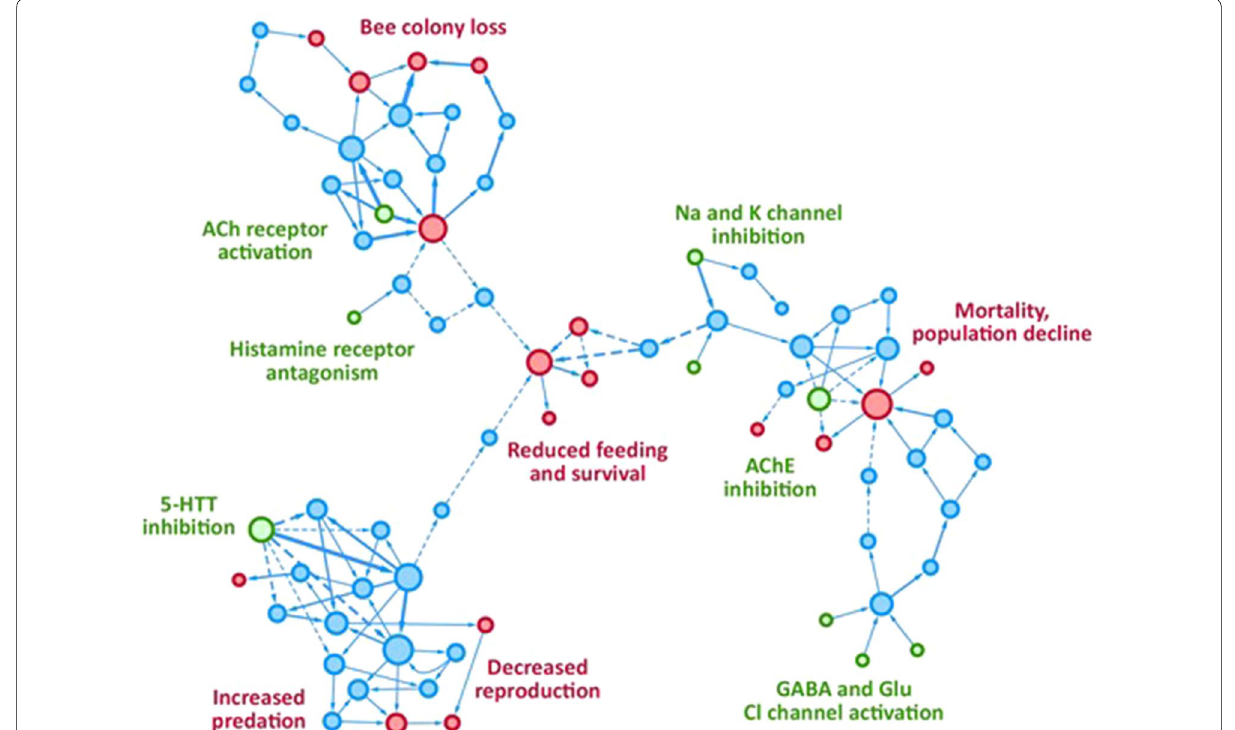
Fig. 4 AOP network showing all AOPs relevant to eco‑neurotoxicity that are available in the AOP‑Wiki (https ://aopwi ki.org; Accession date: April 30, 2018; AOP numbers 16, 77, 78, 79, 80, 82, 87, 88, 89, 90, 91, 93, 94, 95, 97, 98, 99, 113, 160, 161, 178, 195, 197, 203, 204; Network constructed using Cytoscape 3.6.1). Nodes in the network are key events (KEs), and edges represent key event relationships (KERs). Molecular initiating events are displayed in green, adverse outcomes in red. All other KEs are depicted in blue. Solid edges are adjacent KERs, dashed arrows are KERs that have been defined as non‑adjacent (see the OECD’s users’ handbook for developing and assessing AOPs for more information, [333]). Node size represents node degree (the total number of KERs connecting the KE to the network, Villeneuve et al., and edge thickness represents the number of times a given KER is part of constituent AOPs in the network. While some of the AOPs in the network have been published, many are in early stages of development, and none have been reviewed or endorsed by the OECD. This figure and its annotations therefore merely illustrate the current focus areas of eco‑neurotoxicity AOP developers in the AOP‑Wiki, as well as the interrelatedness of these research topics. The AOP network does not make any inference about the scientific validity of the underlying AOPs, nor can it at this stage be used for in‑depth biological interpretation or regulatory application. ACh, acetylcholine; AChE, acetylcholinesterase; 5‑HTT, 5‑hydroxytryptamine (serotonin) transporter; GABA, gamma‑aminobutyric acid; Glu, glutamate; Na, sodium; K, potassium; Cl,